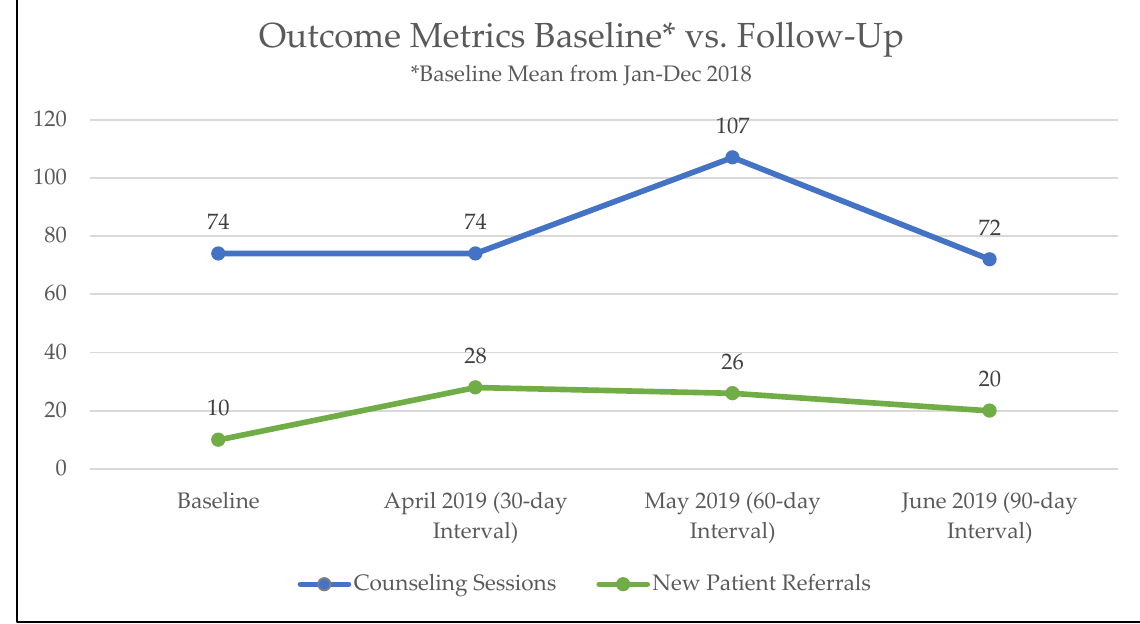
Figure 2. Outcome metrics comparing baseline to follow-up at 30-, 60-, and 90-day intervals.